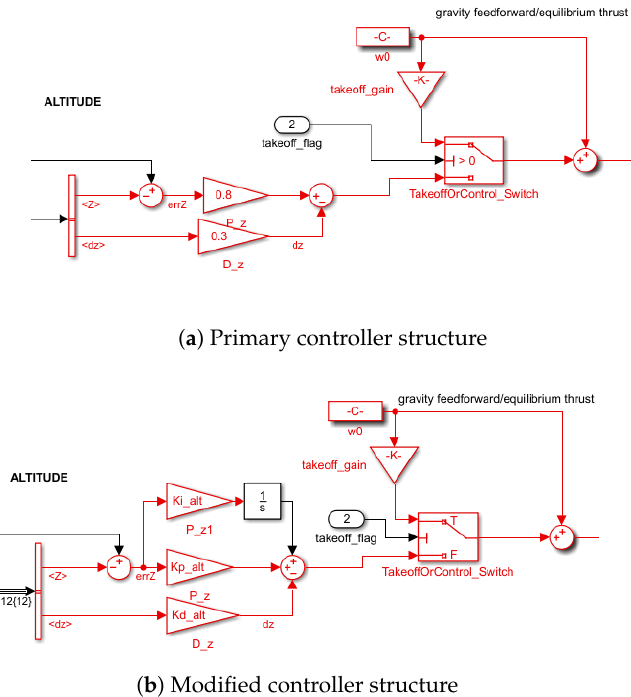
Figure 12. Primary and modified altitude controller structures.